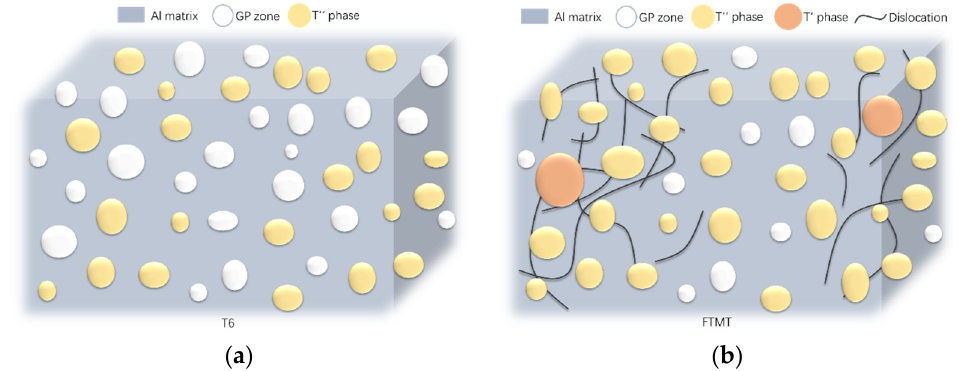
Figure 10. Illustration of intragranular microstructure for Al-Mg-Zn-Cu alloy under di ff erent pro- cesses: ( a ) T6 process; ( b ) FTMT process. cesses: ( a ) T6 process; ( b ) FTMT